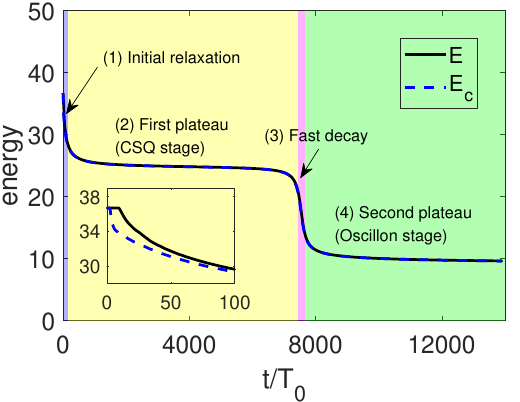
Figure 8. Evolution of total energy E and energy E c , which are defined in section 2.1. t is in the units of the oscillation period of the field T , which is 2 π in the units of 1 /m . Inset: an enlarged 0 view of the initial relaxation phase where there are noticeable differences between E and E . The c constituent elementary Q-balls are initially placed d = 2 . 8 apart from each other, with ω = ± 0 . 86 .